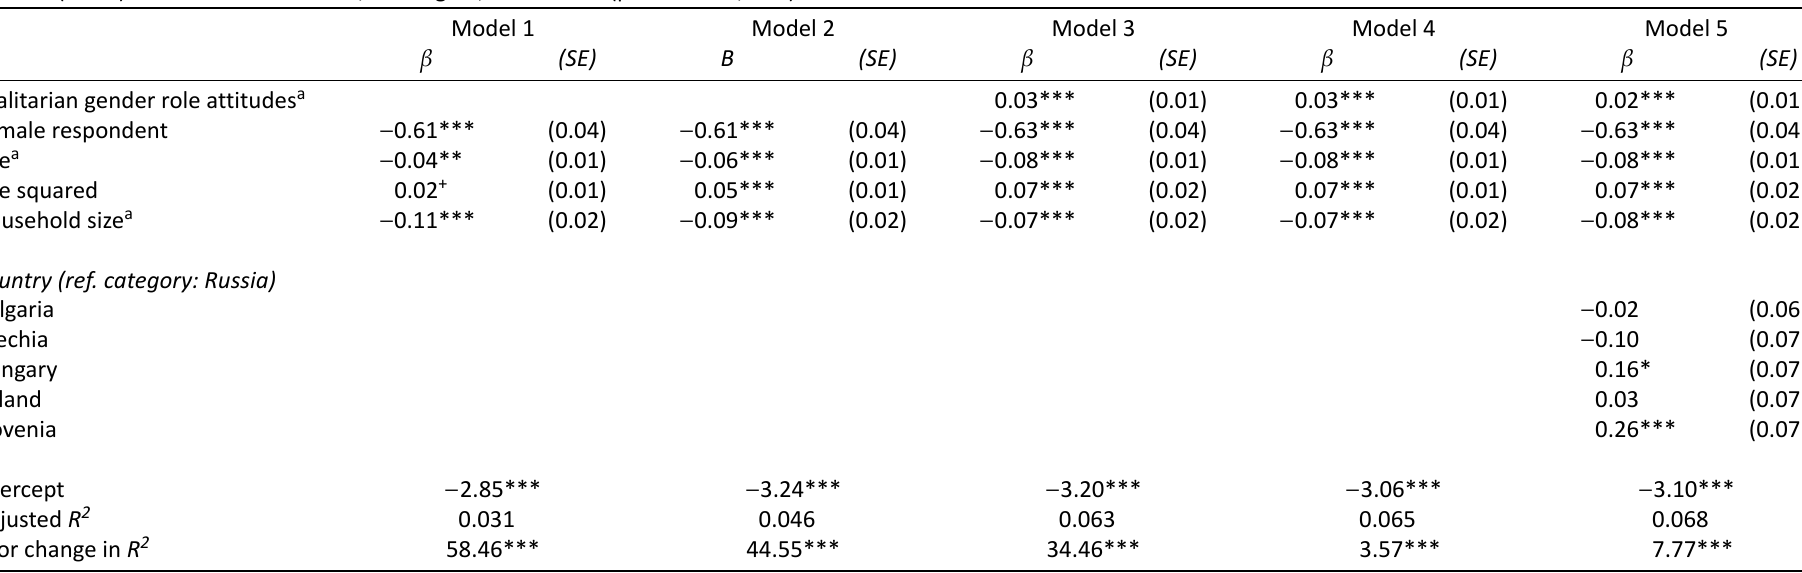
Table 2. (Cont.) Determinants of GDDL, CEE region, 1994–2012 (pooled data,